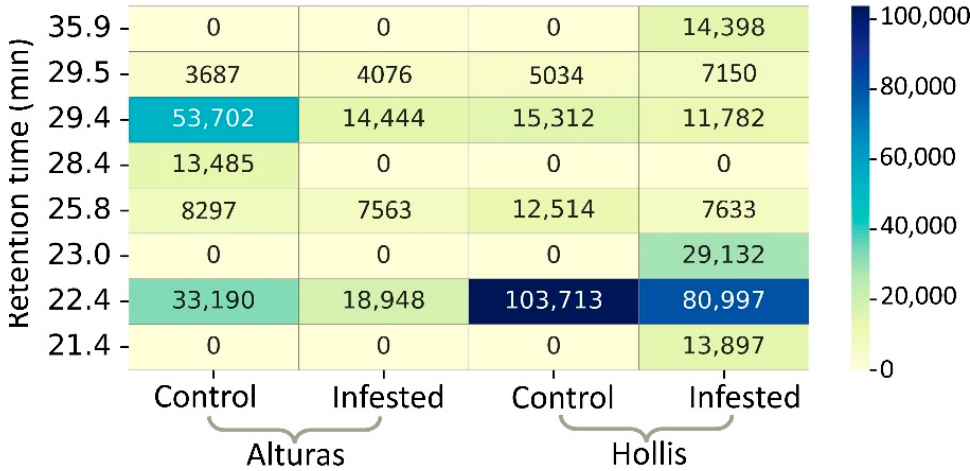
Figure 6. Heat-map showing the peak intensity extracted from GC-FID data of samples from resistant and susceptible wheat infested with Hessian fly.